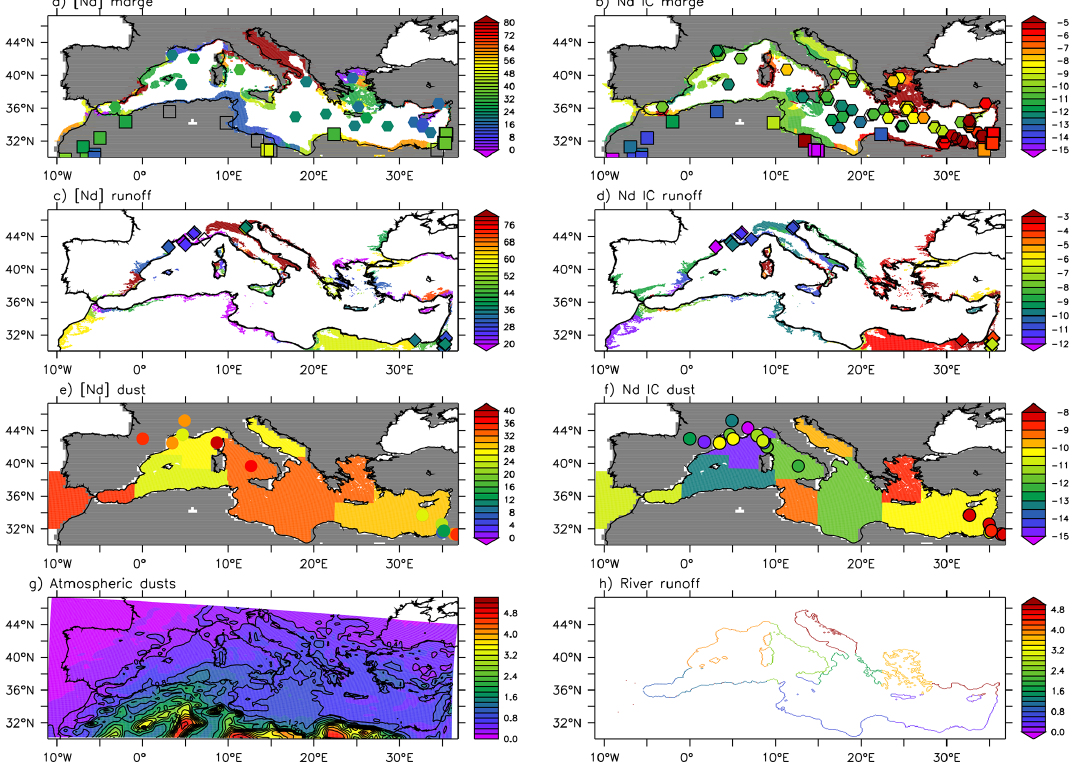
Figure 2. Boundary conditions and input maps applied to the model. (a) Nd concentration ([Nd], in µgg − 1 ) along continental margin determined by Ayache et al. (2016); squares and hexagons represent in situ data from the new global database of Nd provided by Blanchet (2019). (b) Nd isotopic composition ( ε Nd in ε Nd unit) along the continental margin determined by Ayache et al. (2016); squares and hexagons represent in situ data from the new global database of Nd provided by Blanchet (2019). (c) [Nd] of river runoff (in µgg − 1 ) from Ayache et al. (2016) with in situ data from the new global database of Nd provided by Blanchet (2019). (d) ε Nd of river runoff (in ε Nd unit) presented in Ayache et al. (2016) with in situ data from the new global database of Nd provided by Blanchet (2019). (e) [Nd] dust particle fields from the global database of (Blanchet, 2019; Robinson et al., 2021). (f) ε Nd dust particle fields from the global database Blanchet (2019); Robinson et al. (2021). (g) Average deposition fluxes of dust (in gm − 2 ) from the ALADIN climate model (Nabat et al., 2015) (10 6 kgm − 2 s − 1 ). (h) Runoff map prescribed by the NEMO-MED12 model (in 10 5 gm − 2 s − 1 ). Table 3. Estimation of the Nd flux from different sources in the Mediterranean Sea in comparison with the global